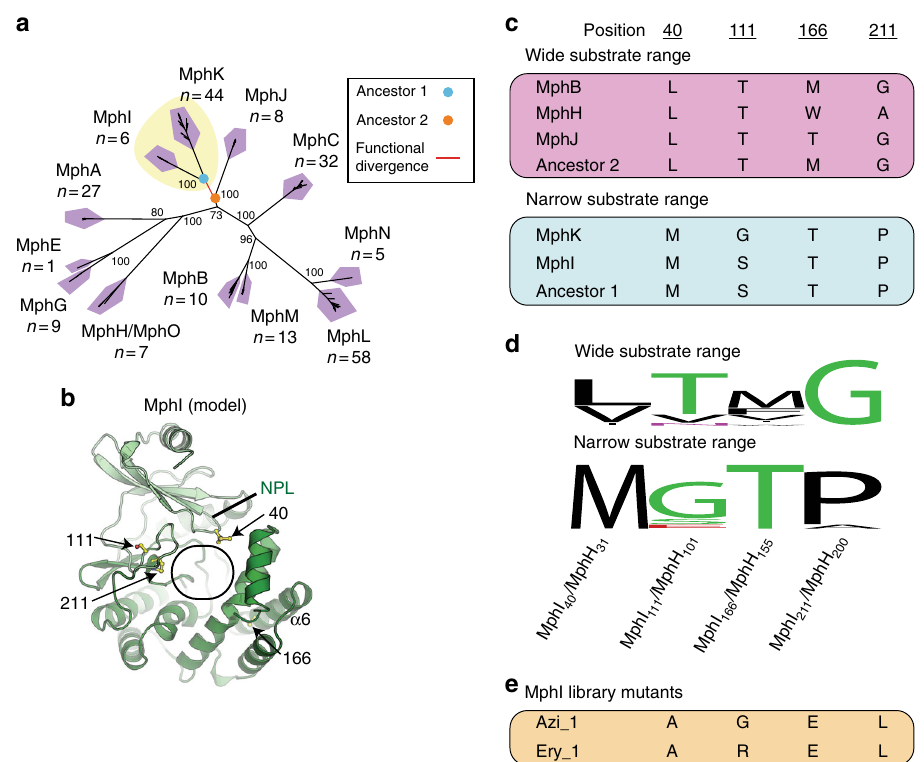
Fig. 5 Ancestral sequence reconstruction of narrow-substrate and wide-substrate range Mphs for identifying possible determinants of substrate speci fi city. a Closely related homologs ( > 80% identity) to known Mphs were used to construct a phylogenetic tree. The tree is presented as an unrooted radial phylogram. The red tree branch represents the point of functional divergence between Mphs that can phosphorylate C3 cladinose macrolides, and those that cannot. The colored circles represent ancestral nodes with reconstructed sequences used to compare important residues. Bootstrap values are indicated at branch points. Numbers underneath Mph names represent the number of unique sequences in each cluster. The yellow background represents clades that do not ef fi ciently phosphorylate macrolides with C3 cladinose. b Model of MphI based on crystal structure of MphH. Oval represents macrolide-binding pocket as determined from MphH • azithromycin crystal structures. Residues identi fi ed by ancestral sequence reconstruction of MphI – MphK divergence are colored in yellow. c Amino acid residues at select positions of narrow-spectrum and wide-spectrum Mphs, and their reconstructed ancestors. d Conservation of residues across the two Mph functional subtypes. Sequence conservation is displayed as a sequence logo using WebLogo. Wide substrate range includes sequences in all clades except MphI and MphK; narrow substrate range includes sequences in only MphI and MphK clades. e Amino acid residues at select positions of MphI library mutants with expanded substrate range comparable to other Mphs ( k cat / K m 10 4 – 10 6 ), and the K m for Table 1 Antibiotic susceptibility of mphI and two library C3 cladinose macrolides is 19 – 69× lower than MphI (Supple- mutants with expanded resistance to C3 cladinose mentary Table 8). In aggregate, these results show that C3 macrolides expressed in E. coli BW25113 Δ bamB Δ tolC cladinose macrolides are good substrates for MphB and other Mphs including MphA 32,44 and MphH 27 (Supplementary Antibiotic Table 2), but are poor substrates for MphI and MphK.